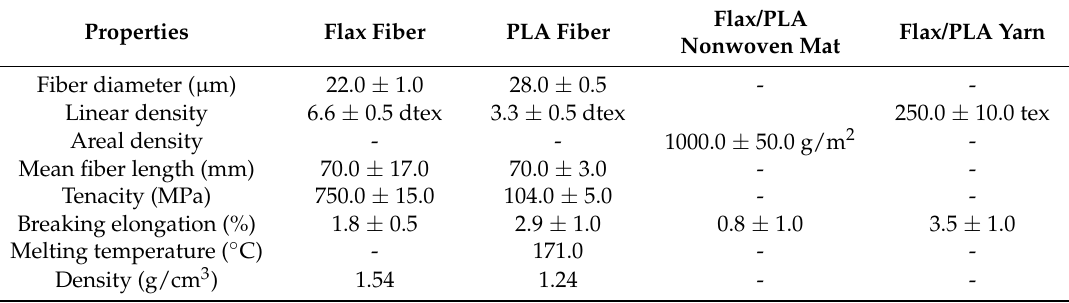
Table 2. Physical properties of flax, PLA fibers and their intermediate